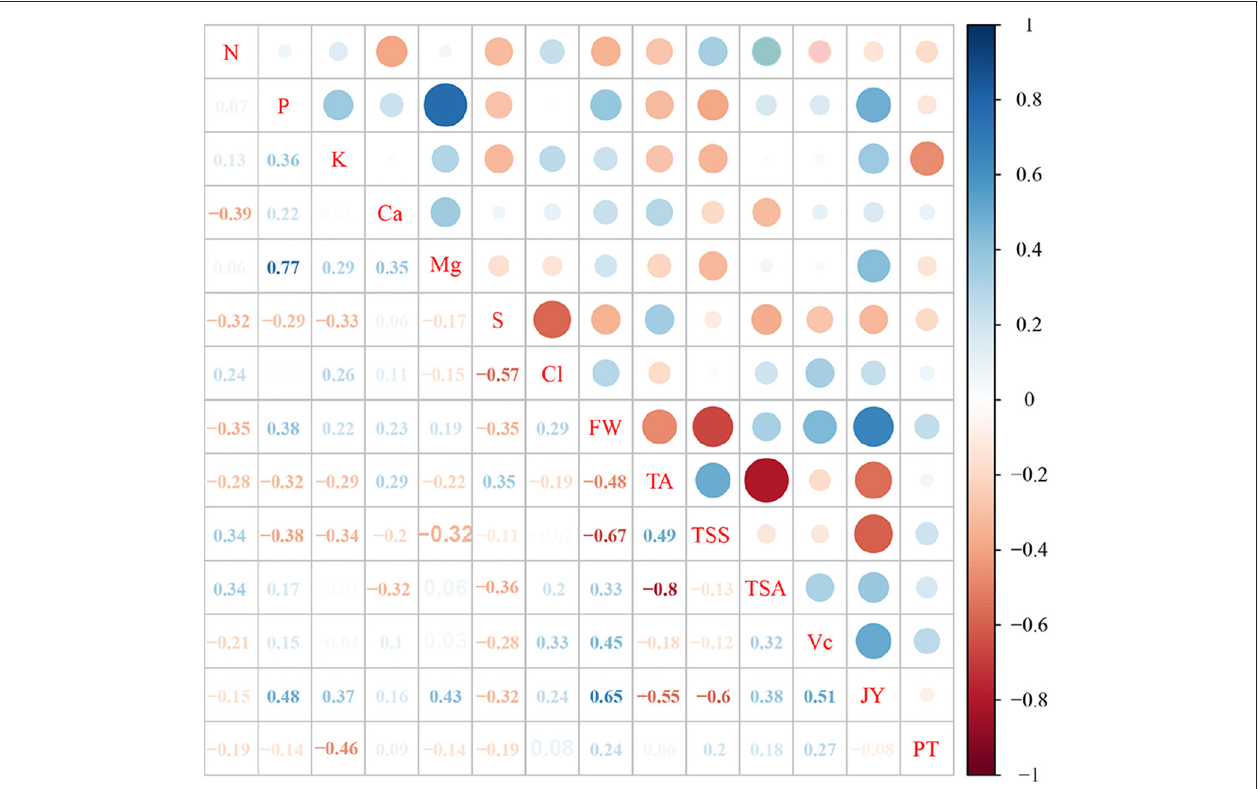
FIGURE 4 | Correlation analyses of leaf mineral nutrients and fruit quality. N, P, K, Ca, Mg, S, and Cl represent the content of N, P, K, Ca, Mg, S, and Cl in the levaes; FW, fruit weight; TA, titratable acid; TSS, total soluble solid; TSA, TSS/TA; Vc, vitamin C; JY, juice yield; PT, peel